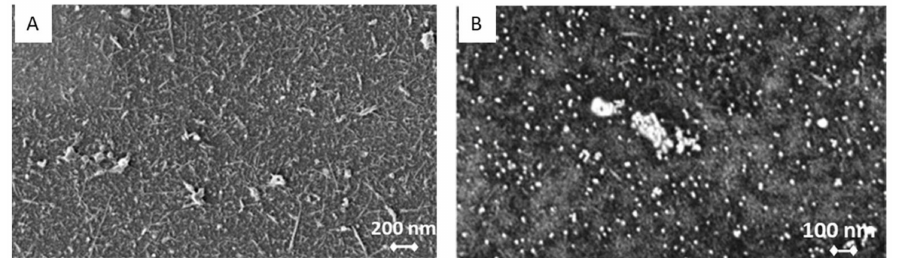
Figure 5. Scanning electron microscope (SEM) image of ( A ) one layer single-walled SWCNT-COOH and ( B ) SWCNT-COOH/GNp + Th.